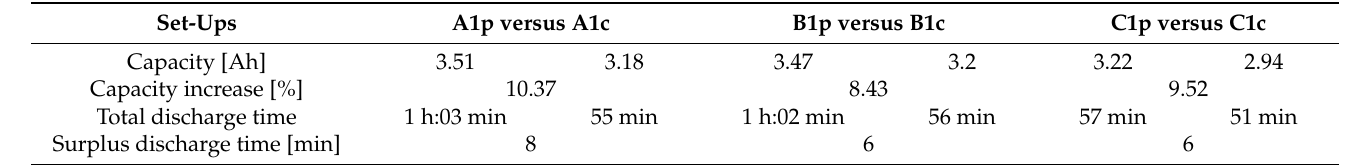
Figure 8. Cells A1A2, B1B2, C1C2 discharging curves; p-pulsed discharge mode, c-continuous discharge mode. Table 3. Discharge data for one battery in pulsed versus continuous discharge.